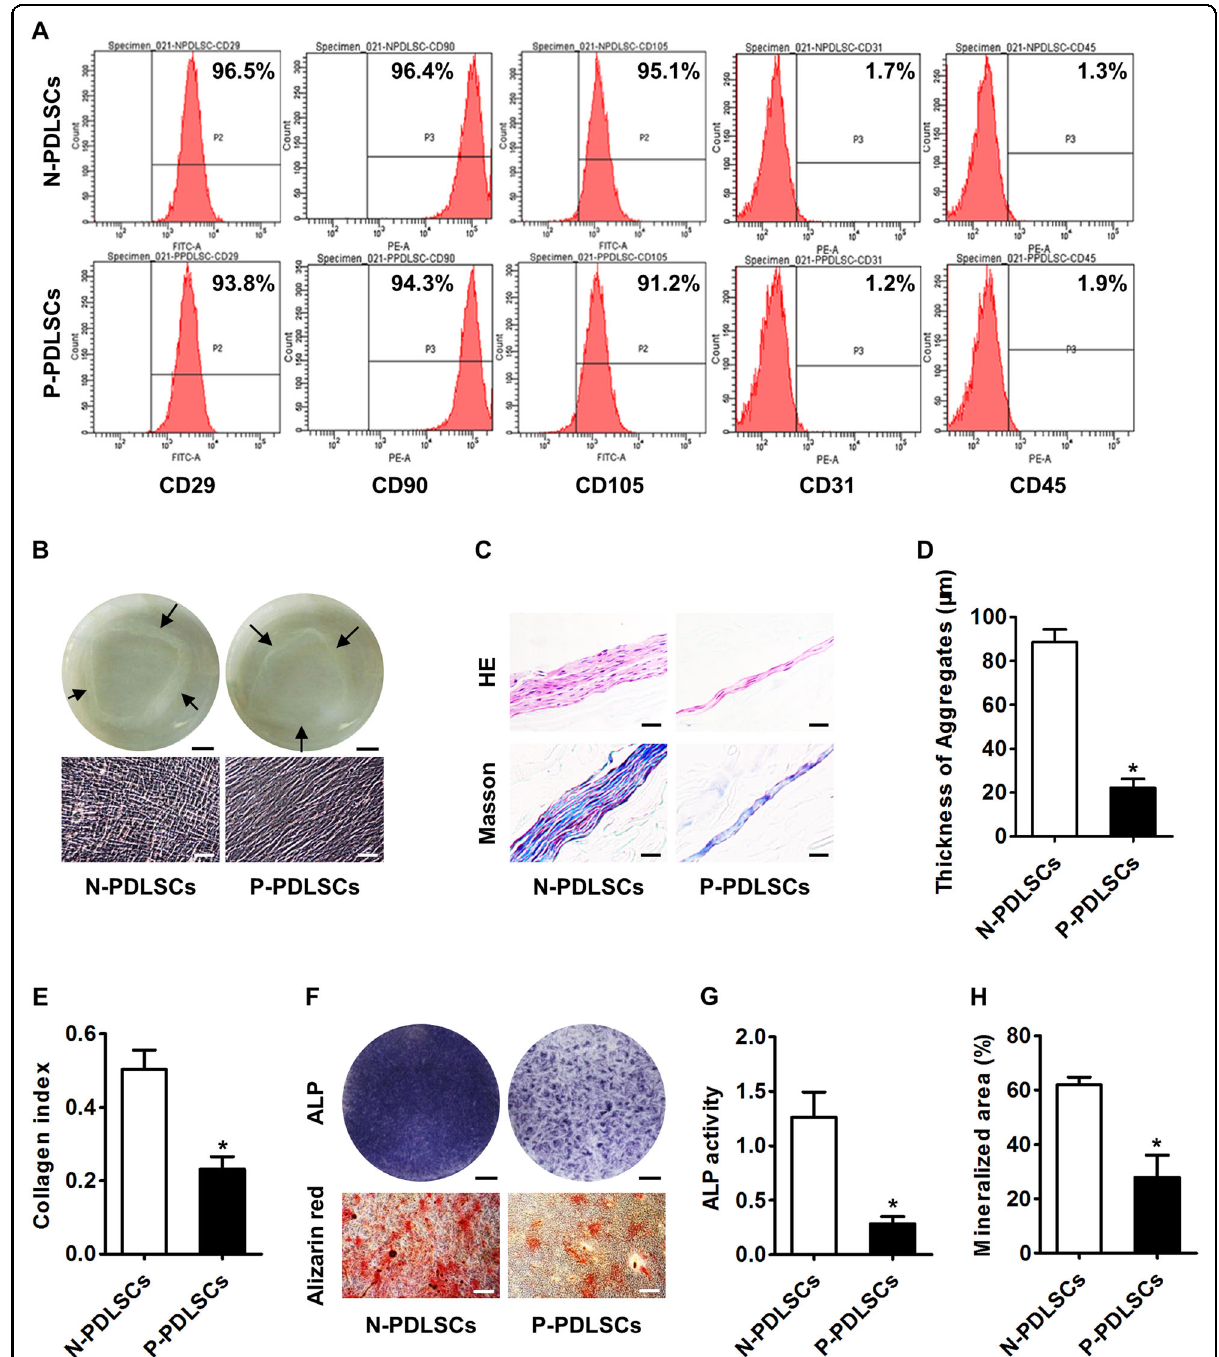
Fig. 1 Mesenchymal stem cells (MSCs) isolated from the periodontal ligaments of patients with periodontitis showed impaired capabilities of cell aggregate formation and osteogenic differentiation. a Flow cytometric analysis of cell surface markers demonstrated successful isolation and culturing of periodontal ligament stem cells (PDLSCs) from subjects showing normal periodontal condition (N-PDLSCs) and patients with periodontitis (P-PDLSCs). b Cell aggregates formed by PDLSCs were observed photographically (top) and microscopically (bottom). Bars: 5 mm (top) and 50 μ m (bottom). c – e Histological analysis of PDLSC aggregates by HE and Masson ’ s trichrome staining ( c ) showed that P-PDLSCs formed thinner aggregates ( d ) with less collagen deposition € . Bars: 50 μ m. f Osteogenesis of PDLSC aggregates demonstrated by alkaline phosphatase (ALP) and alizarin red staining. Bars: 5 mm (top) and 50 μ m (bottom). g , h P-PDLSC aggregates showed lower ALP activity ( g ) and weaker mineralized capability ( h ) in osteogenic differentiation. n = 3 per group ( a ) and n = 6 per group ( b – h ). The data represent the mean ± standard deviation (SD). * P <